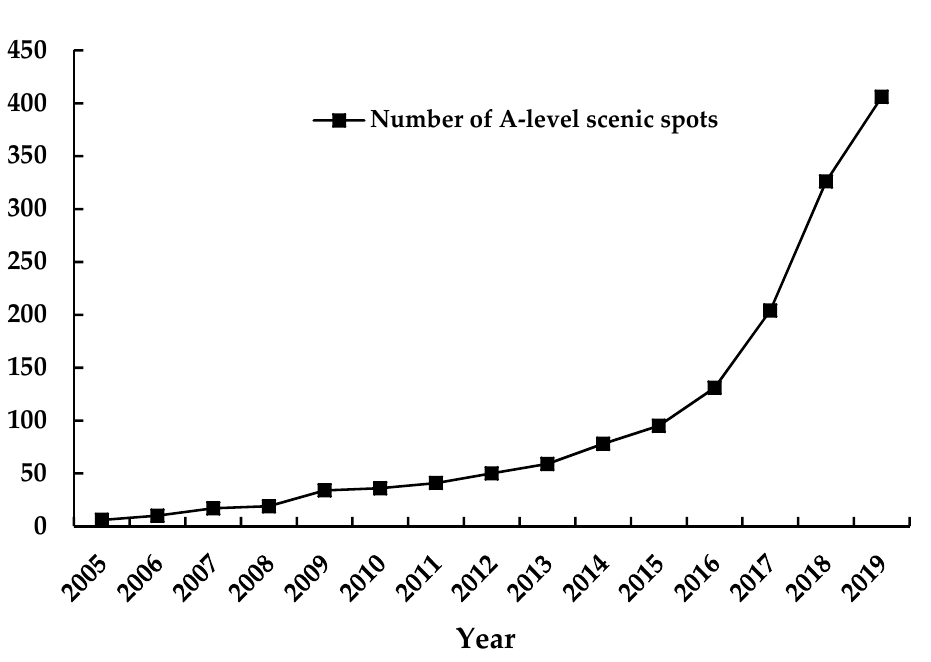
Figure 4. Changes in the number of A-level scenic spots in Guizhou Province (2005–2019).